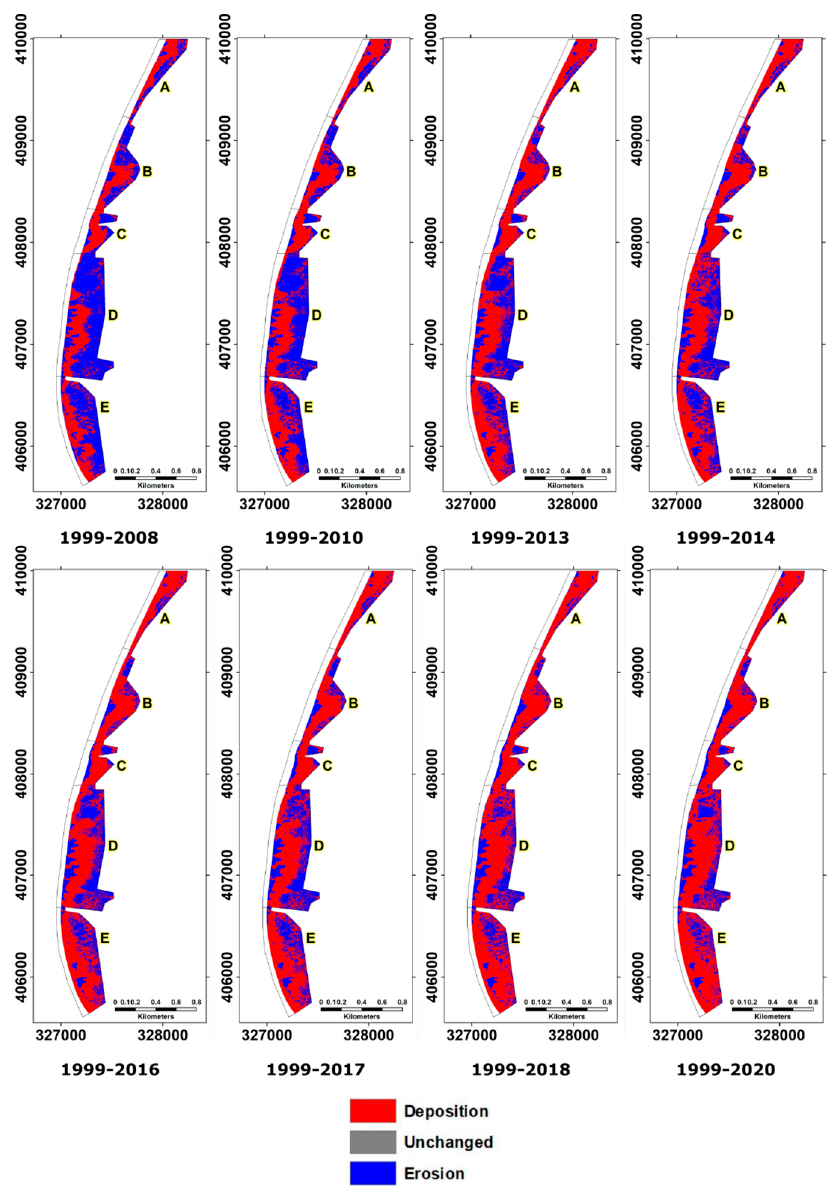
Figure 7. Deposition and erosion maps of the Dunes. This figure shows the volumetric changes and areas of deposition and erosion in the dunes of Formby. The dune areas in all zones are seeing sand deposition